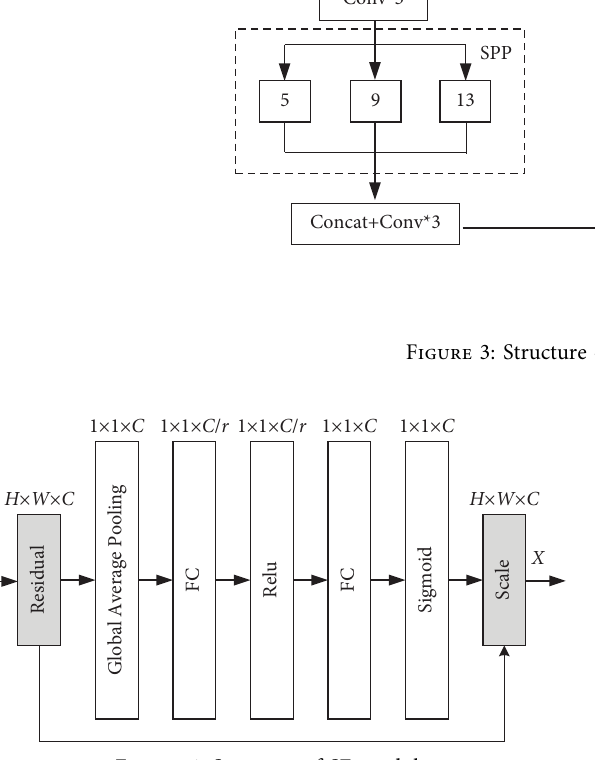
Figure 4: Structure of SE module.